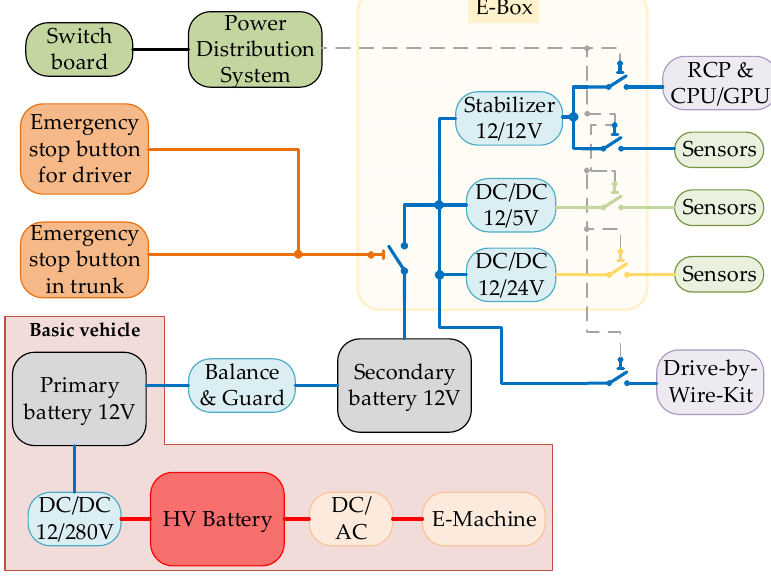
Figure 8. Topology of AFM’s power supply.